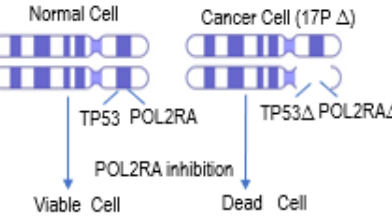
Figure 6. Example of P53 synthetic lethality with POLR2A (RNA polymerase II catalytic subunit), a co-deleted gene with deletion of chromosome 17p that results in vulnerability to POLR2A inhibition and synthetic lethality with α -amanitin.